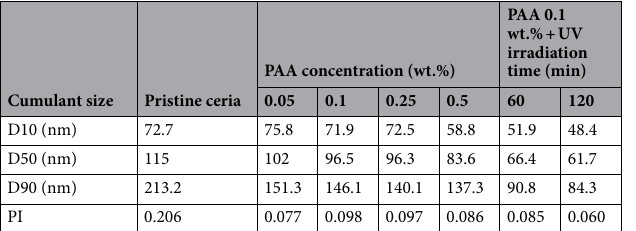
Table 1. The particle size distribution and polydispersity index of ceria slurry according to the concentration of PAA and the duration of UV irradiation.